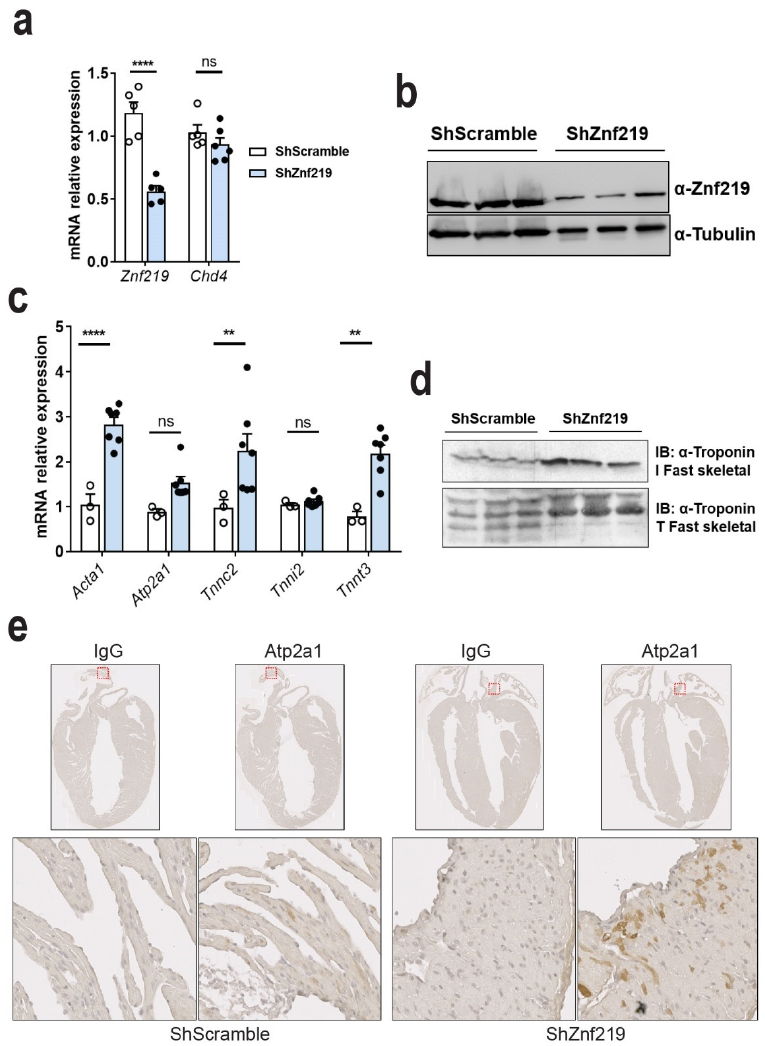
Figure 4. Znf219 represses the skeletal-muscle sarcomeric program in vivo. ( a ) qPCR analysis showing downregulation of Znf219 but no change in Chd4 in mice infected with ShZnf219; paired t-test (two-tailed) **** p -value < 0.0001). ( b ) Western blot showing Znf219 protein expression in ShScramble- and ShZnf219-infected mice. ( c ) qPCR analysis of selected genes encoding sarcomeric skeletal-muscle proteins (two-way ANOVA: ns = not significant; ** p -value ≤ 0.01, **** p -value ≤ 0.0001); ns = non-significant. ( d ) Western blot showing α -troponin I and T fast skeletal protein expression. ( e ) IHC analysis of Atp2a1 in longitudinal heart sections of 8-week-old infected mice. ShZnf219 mice (right) show ectopic atrial expression of